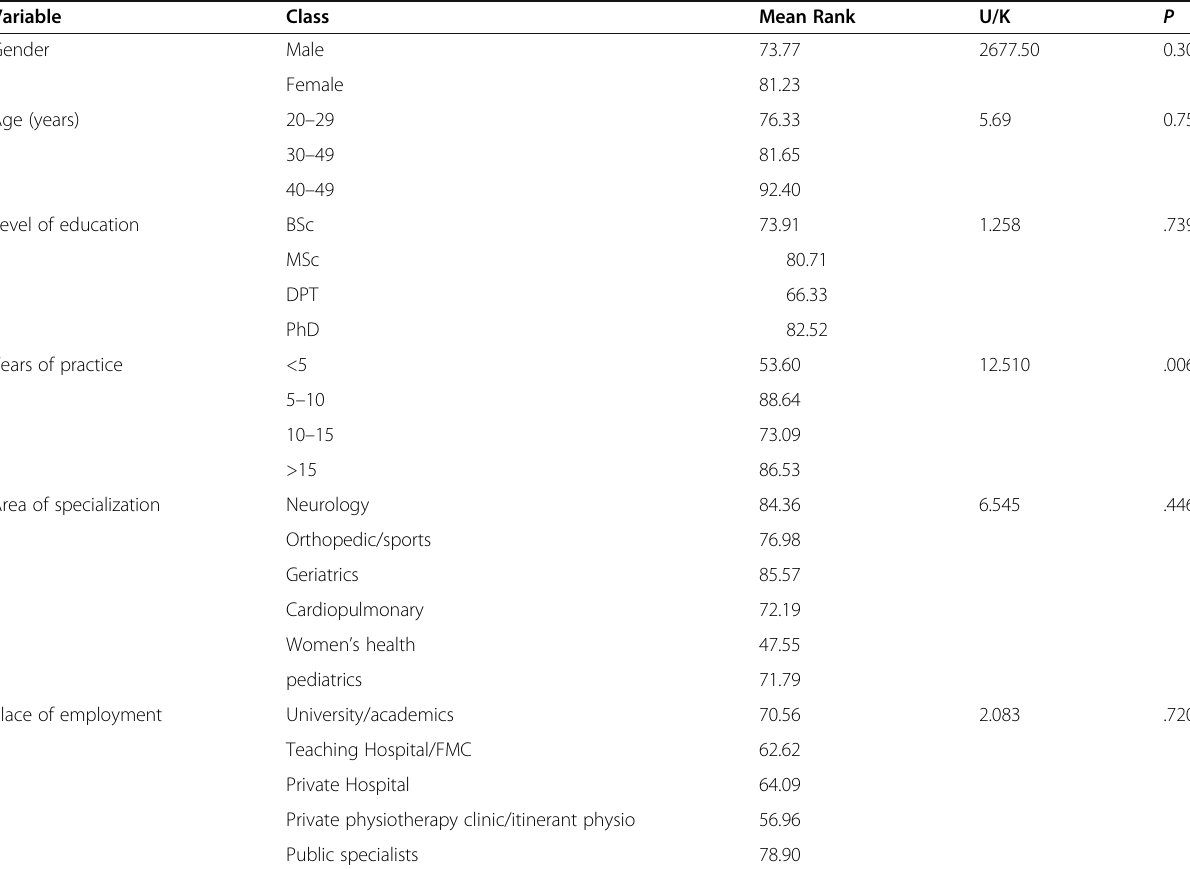
Table 3 Mann-Whitney and Kruskal-Wallis H perception test across different demographic variables Variable